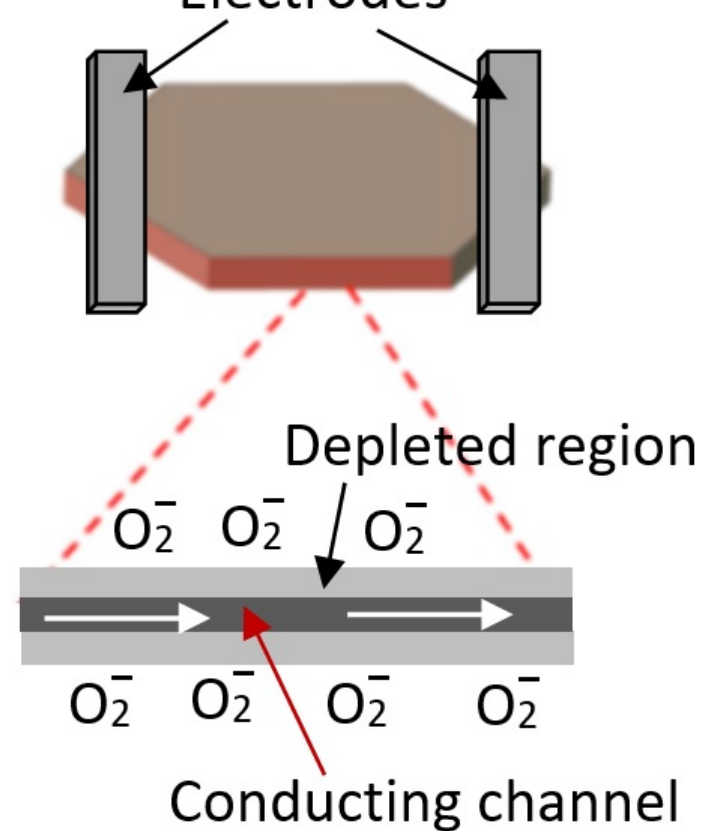
Figure 3. Schematic diagram of gas sensor based on individual 2D nanosheets.